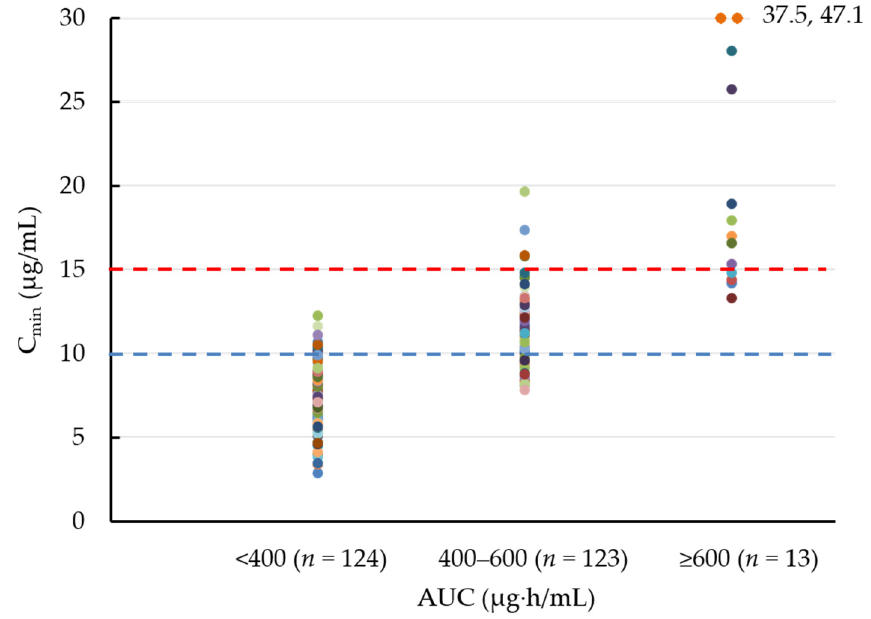
Figure 1. C min distribution in each AUC category on day 2.